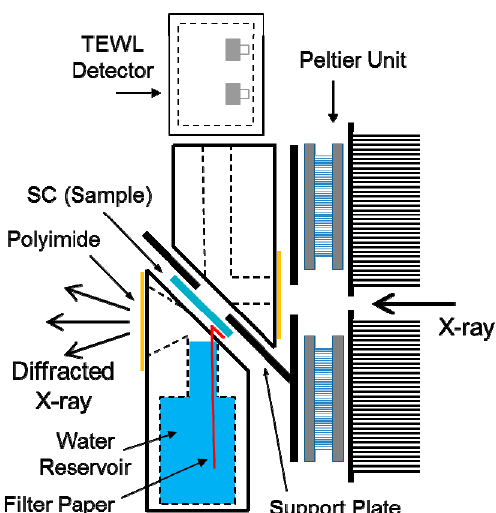
Figure 1. Schematic illustration of the new sample holder designed for simultaneous measurements of the structure and function of a sheet-like sample. The sample is closely attached to the support plate with a small hole at 45° from the direction of the incident X-ray beam and sandwiched between two separable chambers, whose inner environments can be controlled independently. A transepidermal water loss (TEWL) sensor (Tewameter) is attached on the top of the upper chamber to measure water permeability during the X-ray diffraction measurement. Water is filled in the lower chamber and supplied to the underside of the sample through a piece of paper. The position of the upper chamber is slightly shifted in the illustration for the sake of simplicity.